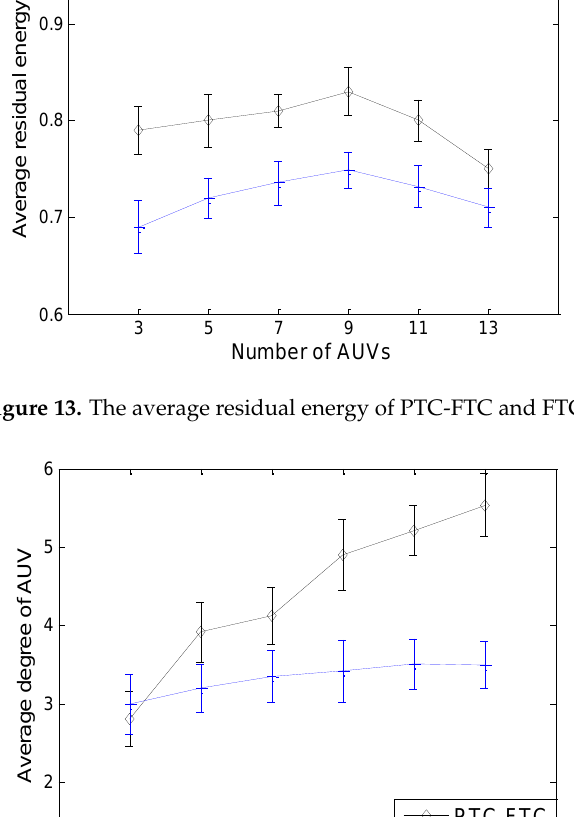
Sensors 2017 , 17 , 1022 Figure 12. The average transmission power adjustment ratio of PTC-FTC and FTC. Figure 12. The average transmission power adjustment ratio of PTC-FTC and FTC.